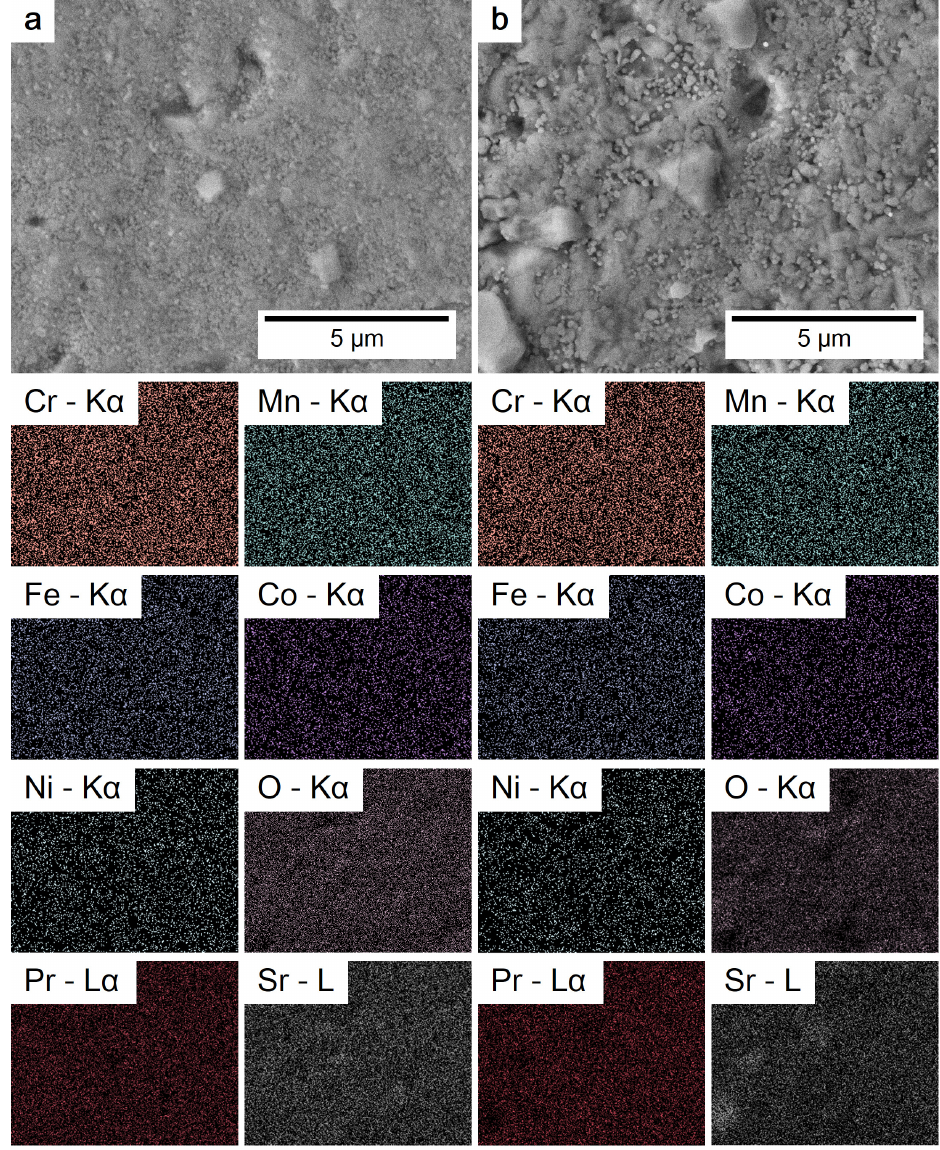
Figure A7. SEM images of the spent Pr 0.5 Sr 0.5 (Cr,Mn,Fe,Co,Ni)O 3– δ membrane and corresponding elemental distributions: ( a ) feed side and ( b ) sweep side. The surfaces were polished prior to the oxygen permeation measurement, and, therefore, no grain boundary is